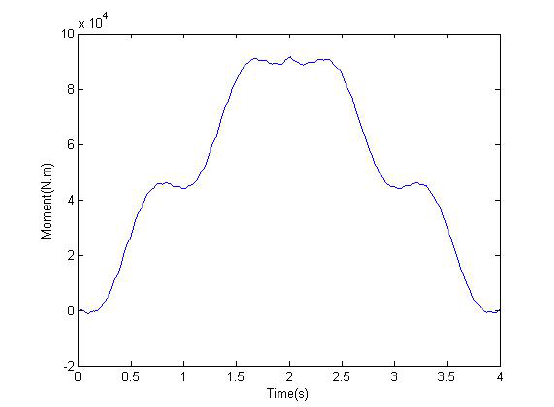
Fig. 2. Bending moment of mid-span point.